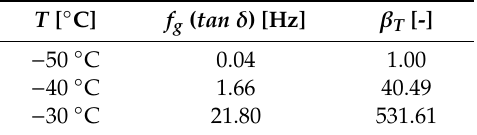
Table 3. Shift factors for reference temperature T 0 = − 50 ◦ C.